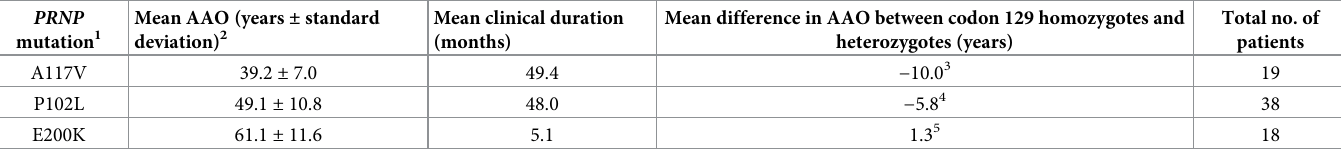
Table 3. Age at clinical onset, duration and difference between IPD codon 129 homozygotes and heterozygotes. Mean AAO (years ± standard PRNP deviation) 2 mutation 1